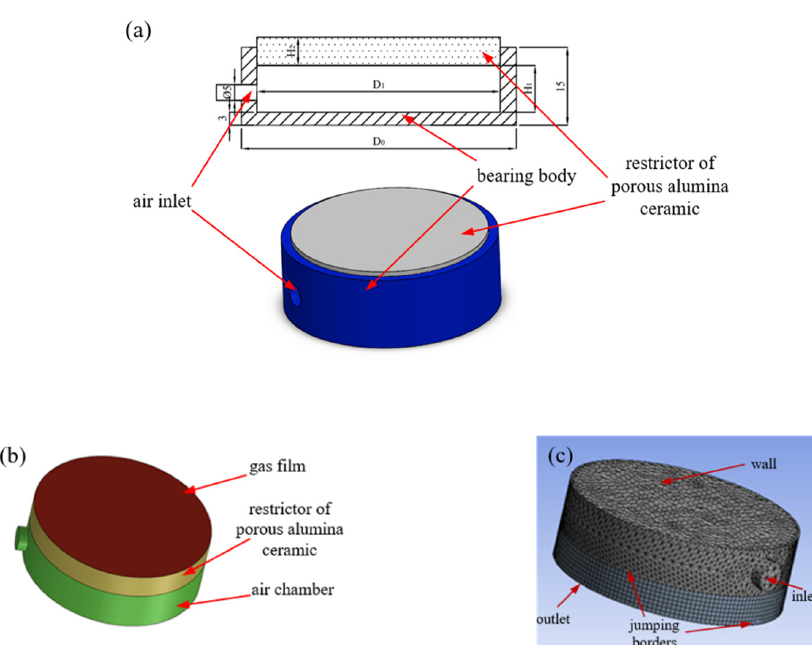
Figure 2. Simulation model of the proposed air bearing: ( a ) geometric model, ( b ) fluid model and ( c ) meshing.